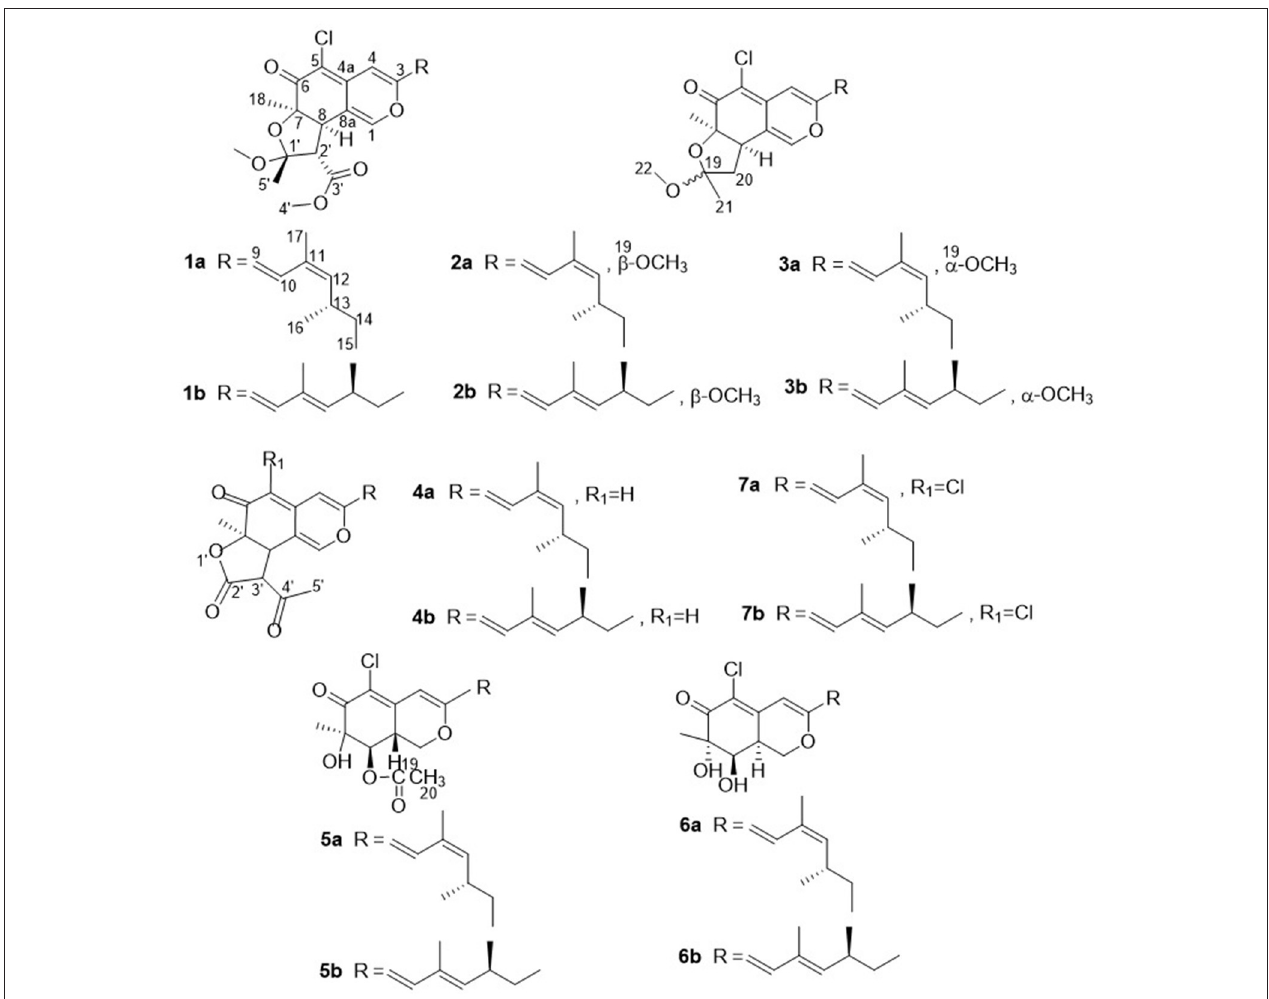
FIGURE 1 | Chemical structures of compounds